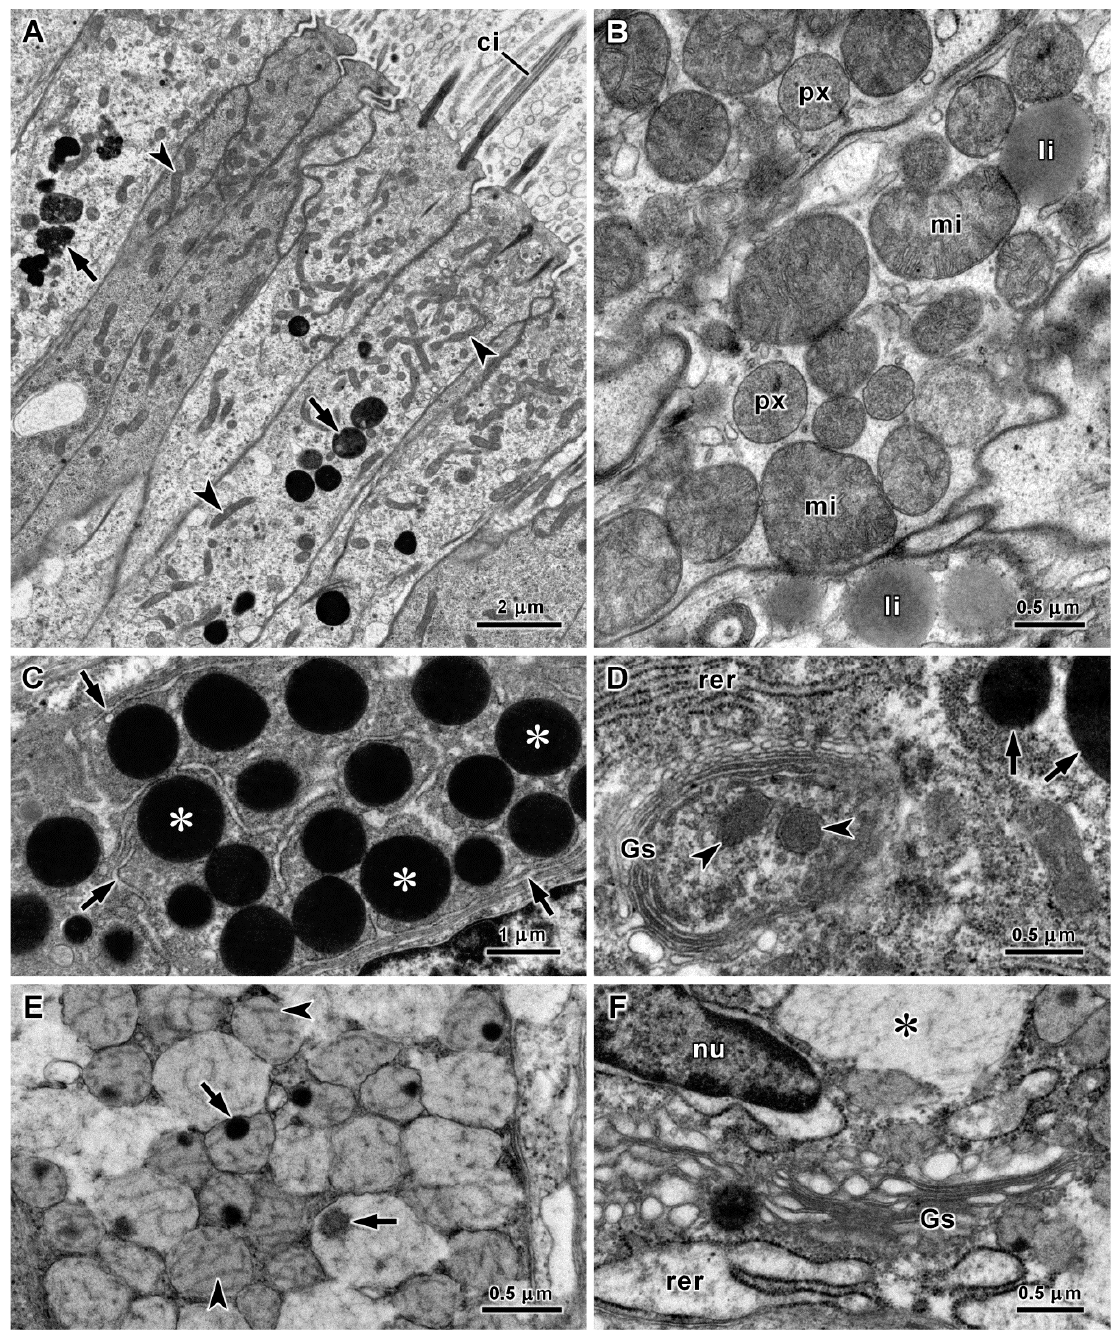
Figure 5. Ultrastructure of the oesophagus in C. angulata ( A , C – F ) and A. fascicularis ( B ). ( A ) Ciliated absorptive cells with several mitochondria (arrowheads) and lysosomes (arrows) in the apical cytoplasm. ( B ) Mitochondria (mi), peroxisomes (px) and lipid droplets (li) in the basal region of an absorptive cell. ( C ) Basophilic cell with electron-dense secretory vesicles (asterisks) and flattened cisternae of rough endoplasmic reticulum (arrows). ( D ) Golgi stack (Gs) and associated vesicles (arrowheads) with a content less electron-dense than the mature secretory vesicles (arrows) in a basophilic cell. ( E ) In mucus-secreting cells vesicles contained an electron-dense spot (arrows) and filaments (arrowheads). ( F ) Golgi stack (Gs) and dilated cisternae of rough endoplasmic reticulum (rer) in a mucus-secreting cell. Vesicle fusion created vacuoles with secretory products (asterisk). ci—cilium, nu—nucleus, rer—rough endoplasmic